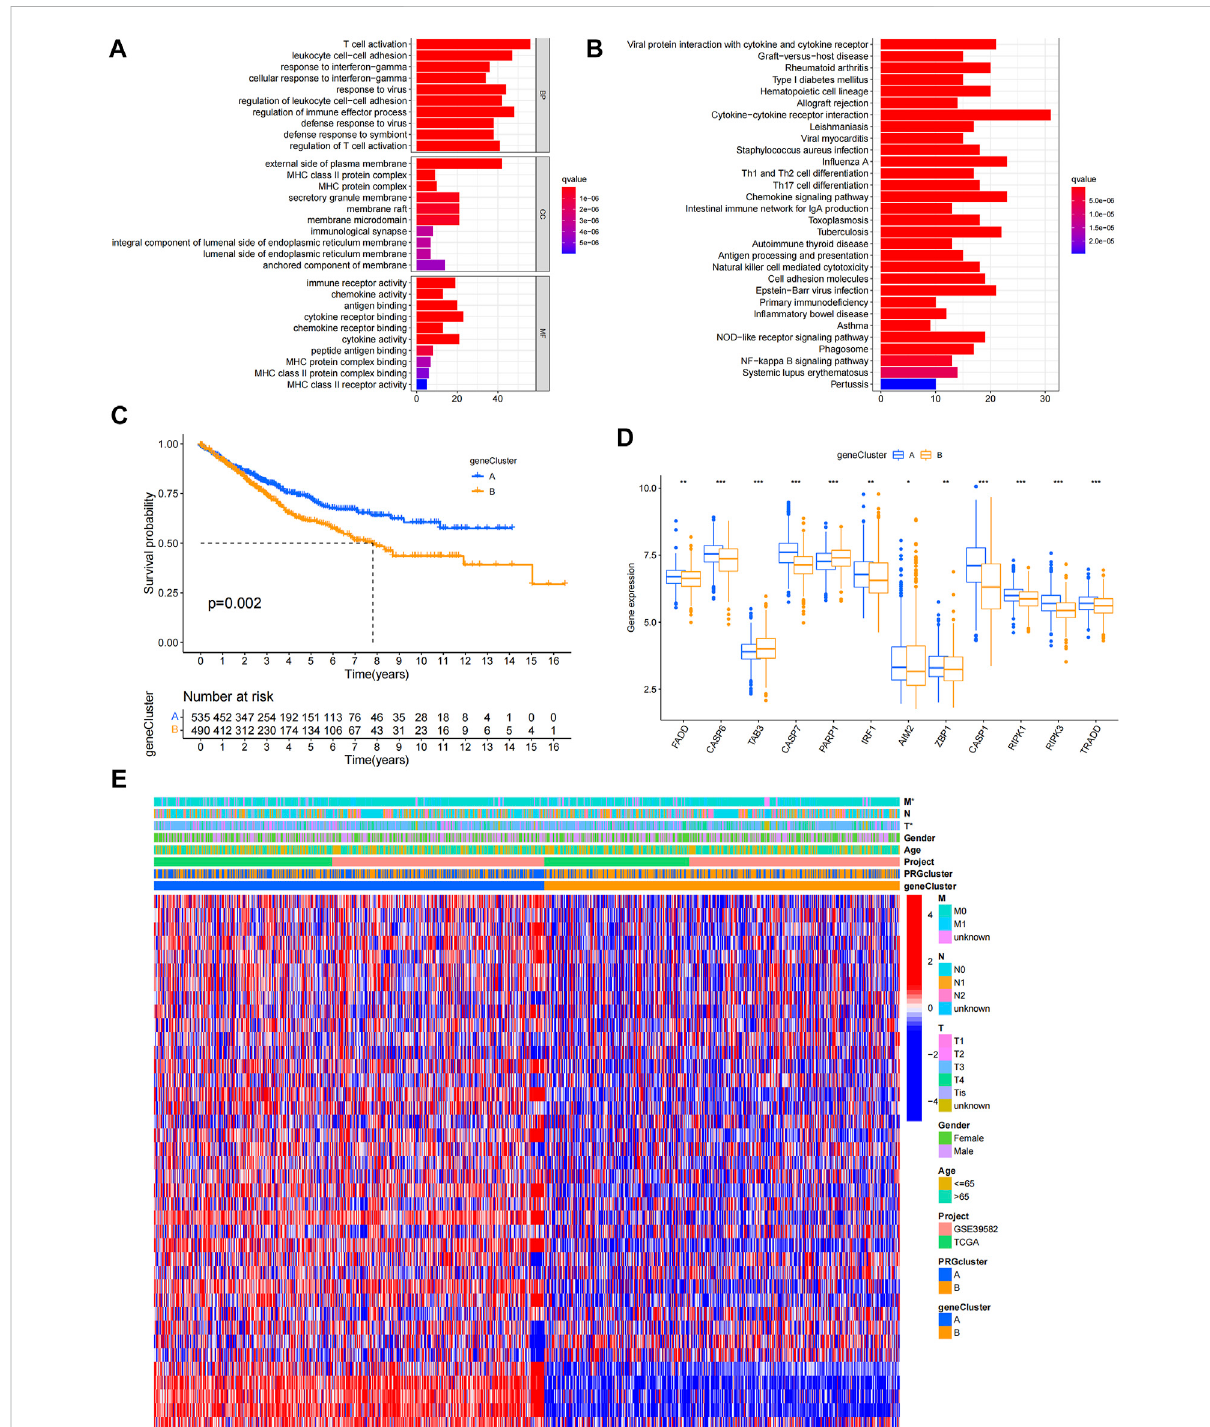
FIGURE 3 Identi fi cationofgeneclustersbasedonDEGs. (A – B) GOandKEGGanalysesshowedtherelevantbiologicalprocesses(BP),cellularcomponents (CC),molecularfunctions(MF)andpathways. (C) Heatmapshowedtheassociationbetweengeneclusterandclinicalfeatures. (D) KMcurvesshowed genecluster A had a more favorable prognosis. (E) Expression levels of PRGs in two geneclusters. * p < 0.05; ** p < 0.01; and *** p <